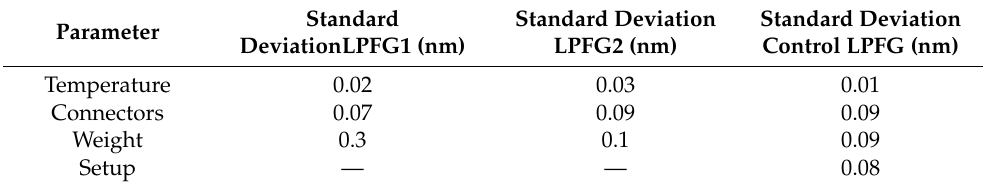
Table 1. LPFGs standard deviation values of repeatability measurements with optical